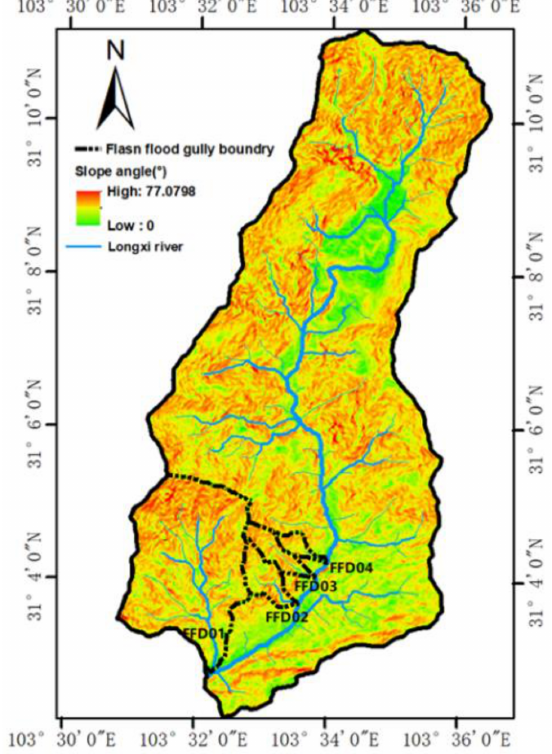
Figure 10. The slope figure of the Longxi River basin.